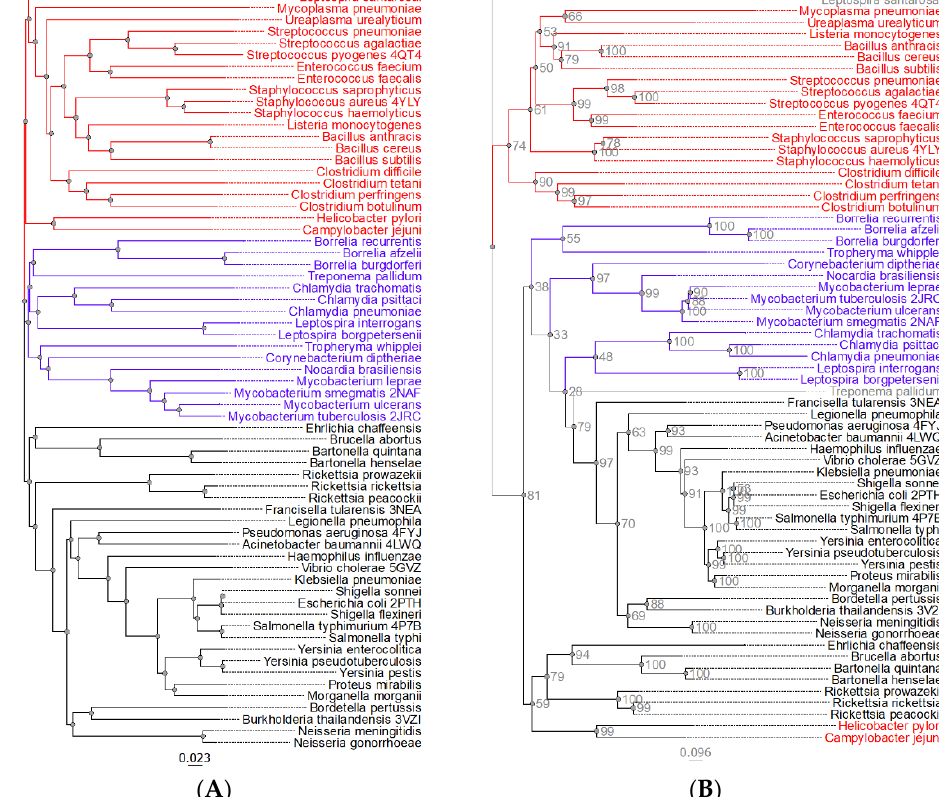
Figure 2. The Phylogenetic Relationships of Pth1 from Pathogenic Bacteria. ( A ) Shown are the simple phylogenetic relations for Pth1 from pathogenic bacteria. The intermediary Clade 2 is colored blue. Pth1 with known structures have the 4 character PDBID after the name. ( B ) Shown is the phylogenetic tree generated in IQTREE [28,29] with bootstrap values indicated. Coloring reflects grouping identified in the simple phylogenetic analysis. Bootstrap values are shown in gray.